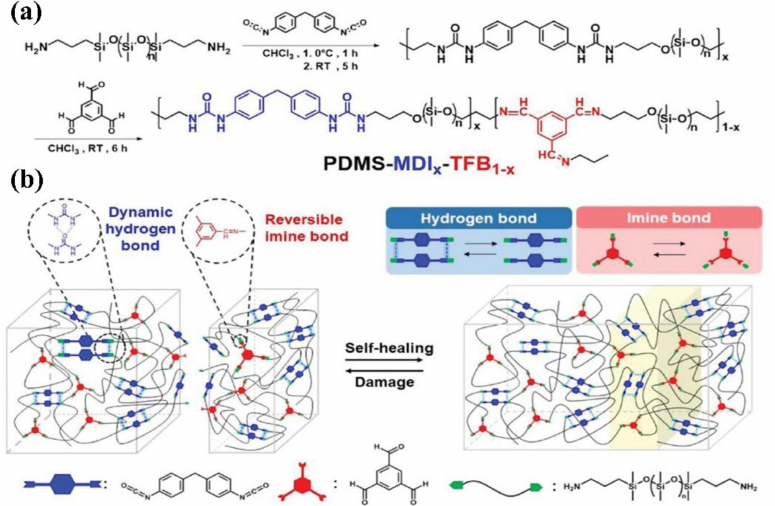
Figure 8. ( a ) Synthetic route to prepare PDMS-MDIx-TFB1-x self-healing elastomer. ( b ) Schematic illustration of ideal structure of PDMS-MDI x -TFB 1 − x based on the synergistic effect of reversible weaker imine bonds and stronger hydrogen bonds. Reproduced with permission from [93]. Copyright 2021 Wiley-VCH